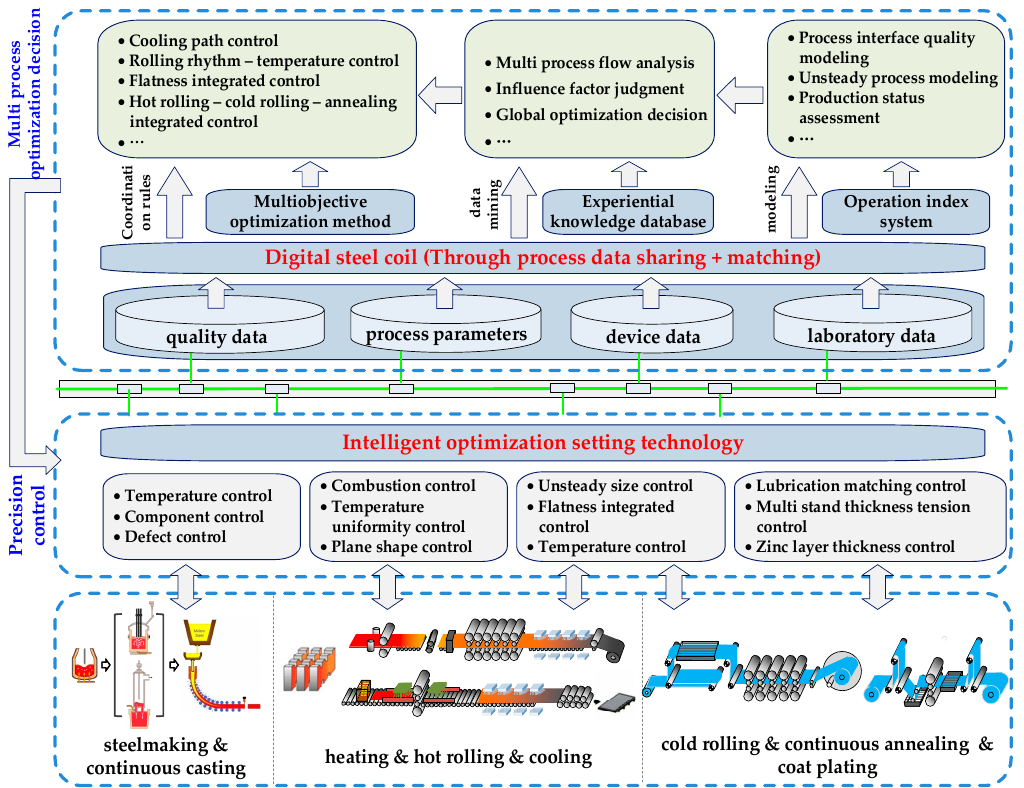
Figure 3. Coordination and optimization of multi-process and precision control of product quality.